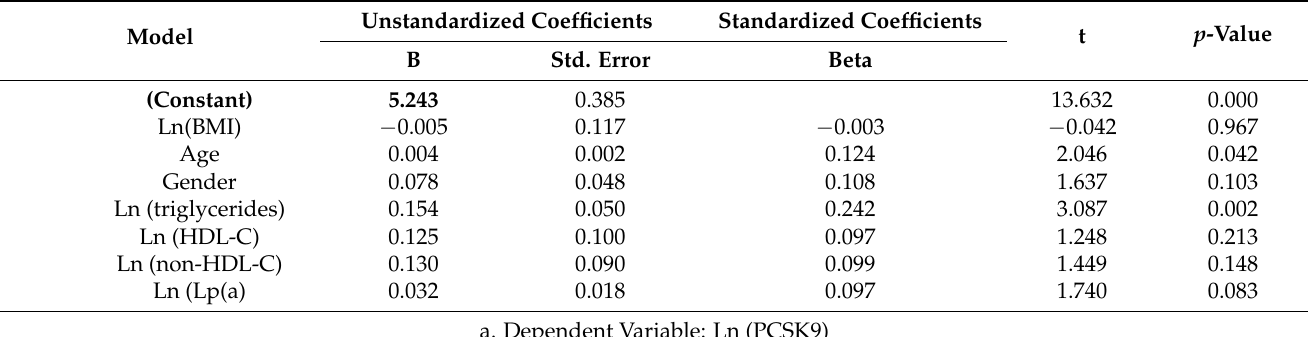
Table 5. Multiple linear regression analysis with PCSK9 as a dependent variable and gender, age, BMI, SES, non-HDL-C, triglycerides, and HDL-C as independent